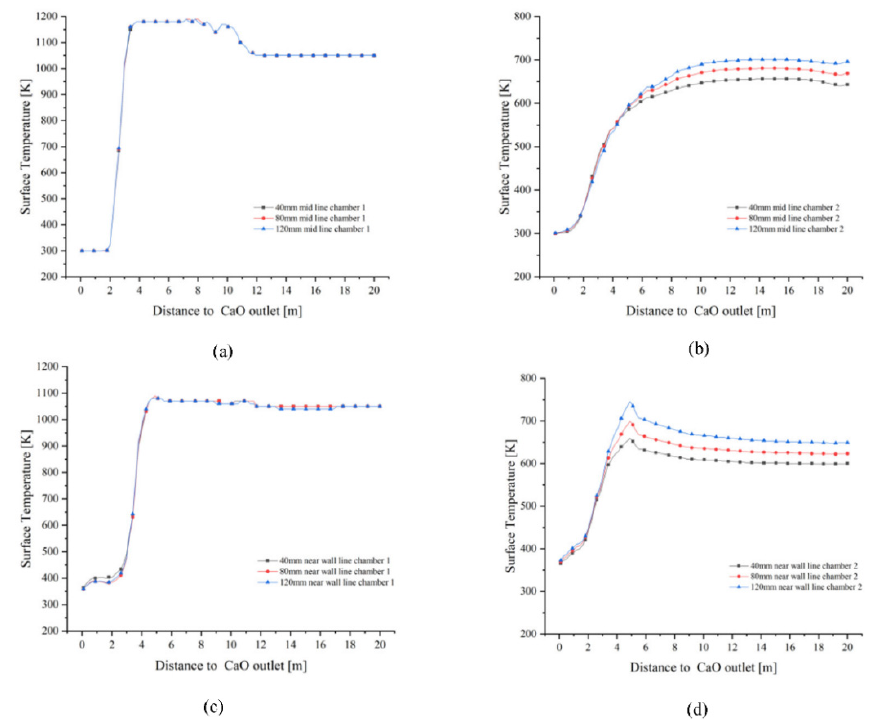
Figure 13. Comparison of solid surface temperature variations in the mid line and near wall line of chamber 1 and 2. ( a ) Change in solid surface temperature at the mid line of chamber 1; ( b ) Change in solid surface temperature at the mid line of chamber 2; ( c ) Change in solid surface temperature at near wall line of chamber 1; ( d ) Change in solid surface temperature at near wall line of chamber 2.